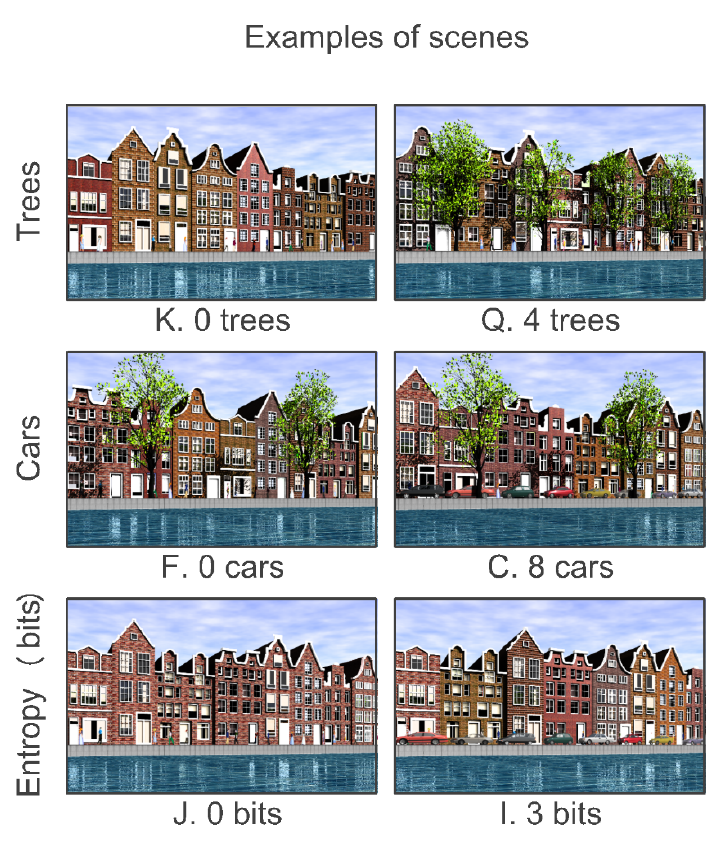
Figure 9. Design features and options for “New”